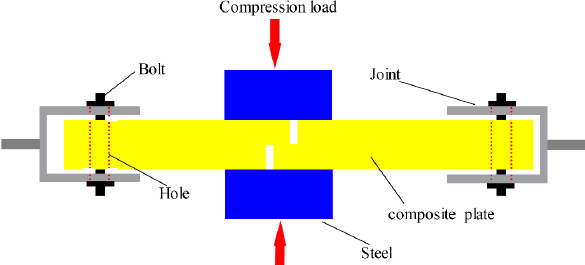
Figure 2: Conversion joint